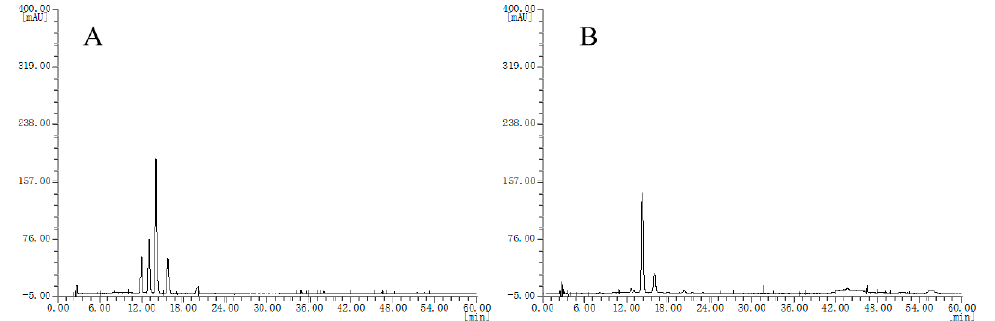
Figure 2. HPLC chromatograms of the blueberry extracts, ( A ), chromatogram type of B2 and B3 samples; ( B ) chromatogram type of B1, B4, B5, B6 and B7 samples.